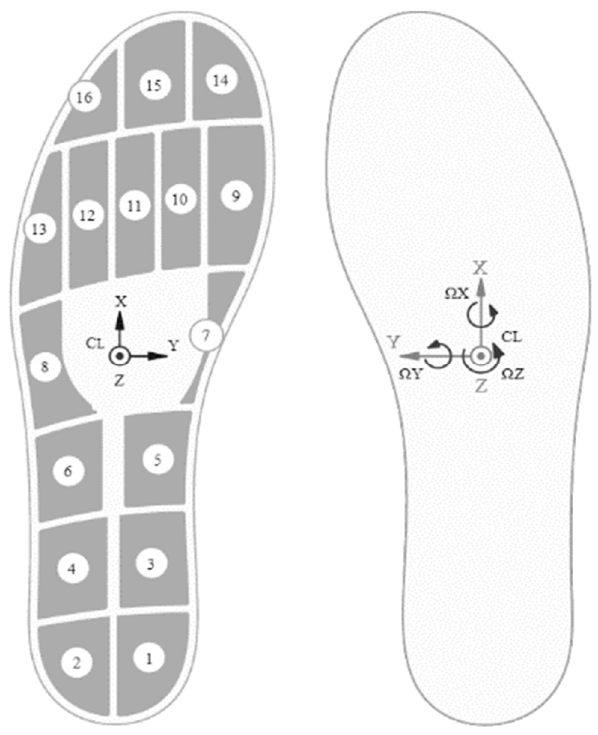
Figure 2. The Moticon SCIENCE pressure sensor insole (model insole 3). Reproduced with permis- sion from Moticon ReGo AG [14].